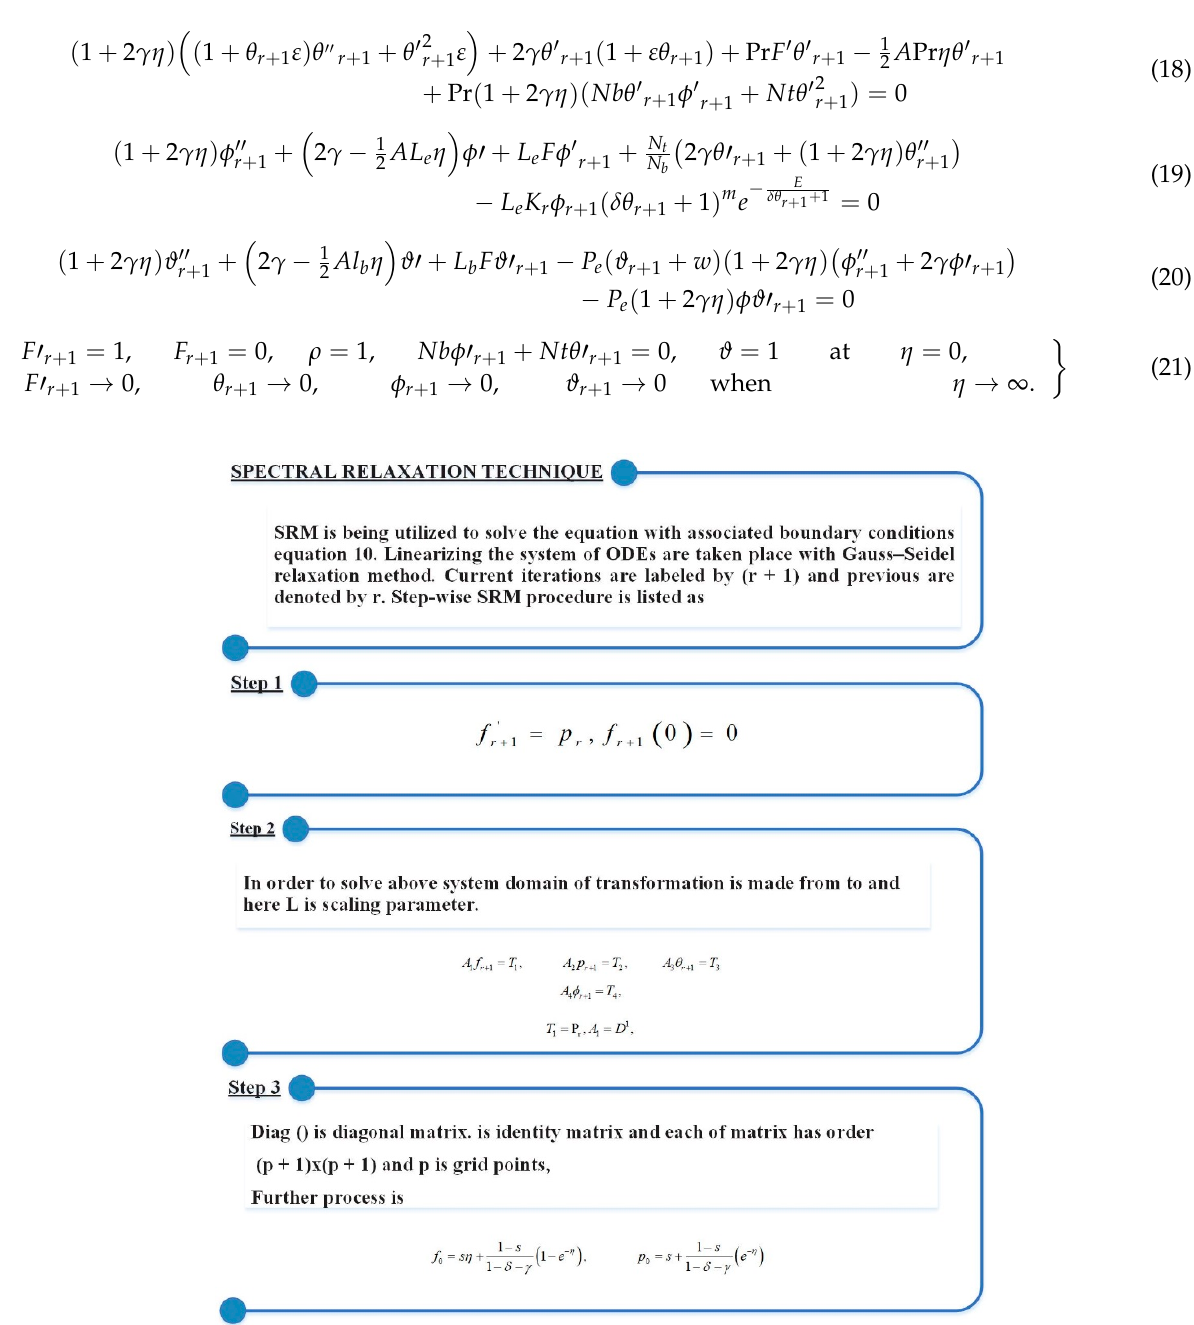
Figure 2. Flow chart of SRT.